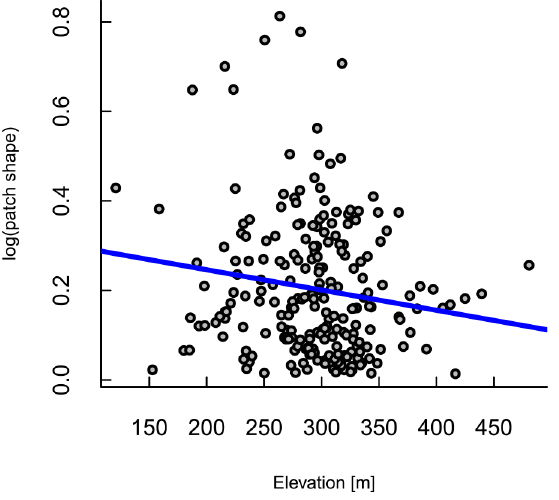
Fig 4. Scatterplot of the final regression model of drought impact patch shape as a function of elevation. No other environmental variables assessed were related to patch shape.